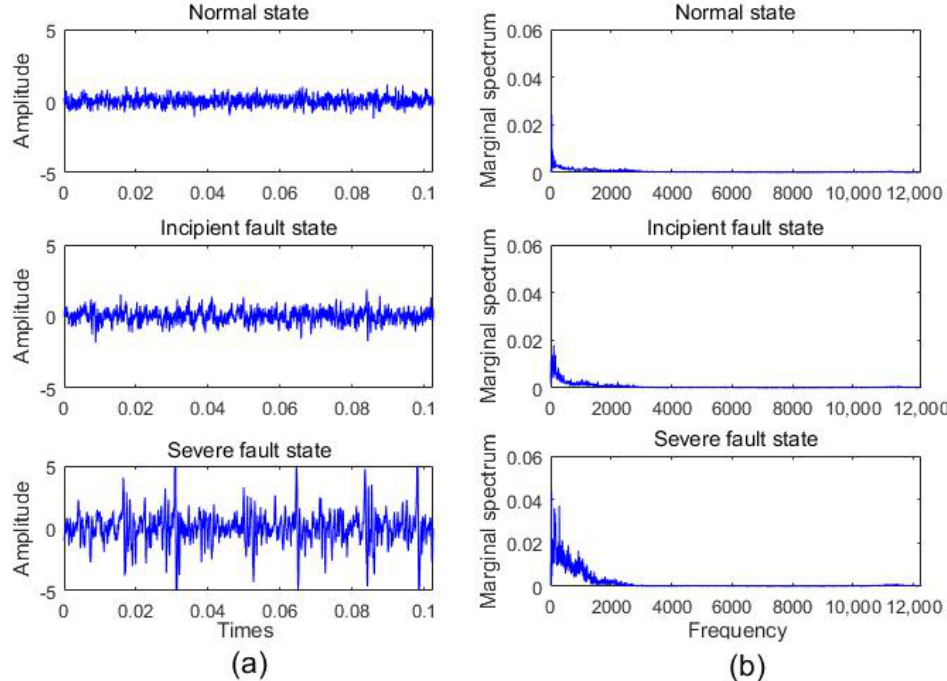
Figure 9. The ( a ) raw time signal and ( b ) HHT marginal spectrum of the bearing 1 from IEEE PHM Challenge 2012